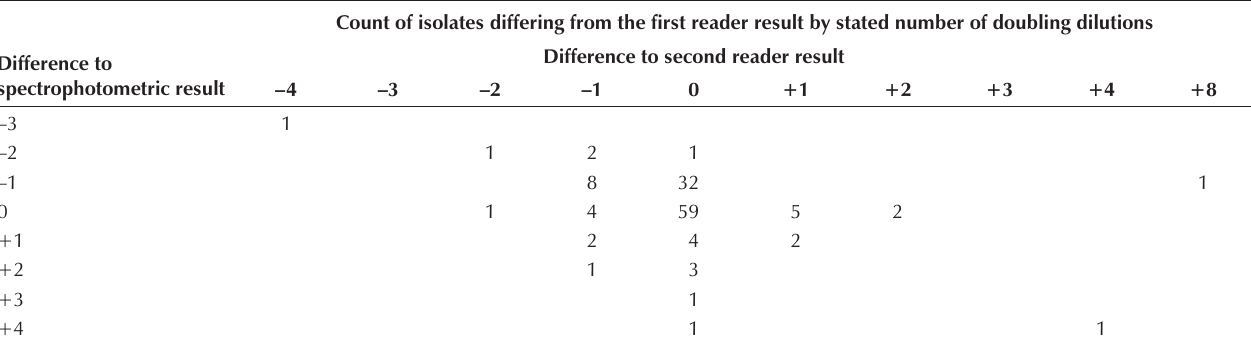
*Count excludes duplicate isolates from individual patients within seven days, as described in Specimens and Methods section Comparison between fluconazole minimum inhibitory concentration determined by first reader and second reader and by spectrophotometric interpretation Count of isolates differing from the first reader result by stated number of doubling dilutions Difference to spectrophotometric